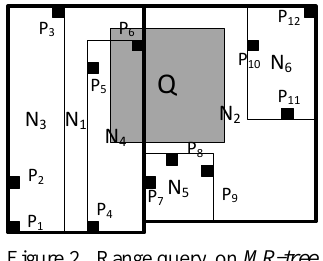
Figure 2. Range query on MR-tree